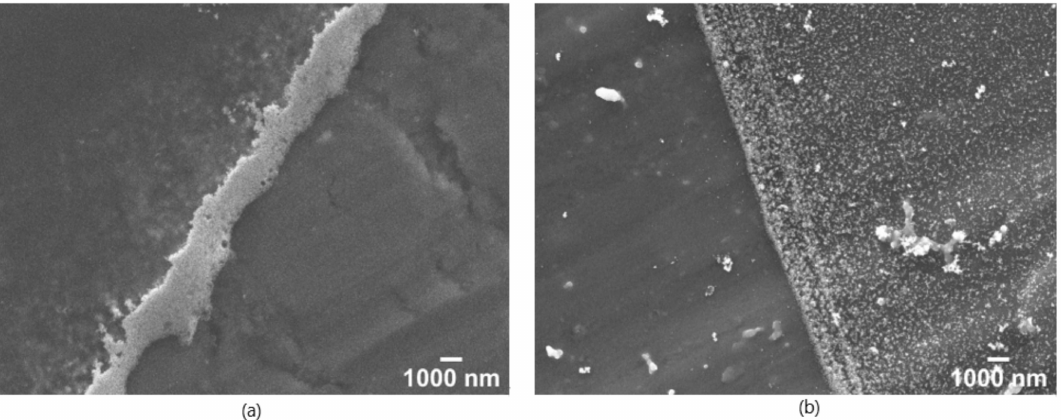
Figure 8. SEM image of the edge region of two SERS substrates at a 5000 × magnification with a WD 6 mm and 15 kV acceleration voltage. ( a ) On the left side AuNPs are coated onto the untreated aluminium plates. ( b ) On the right side the AuNPs were coated onto a 4% TTIP coated and calcinated at 600 ◦ C for 5 h plasma treated substrate.